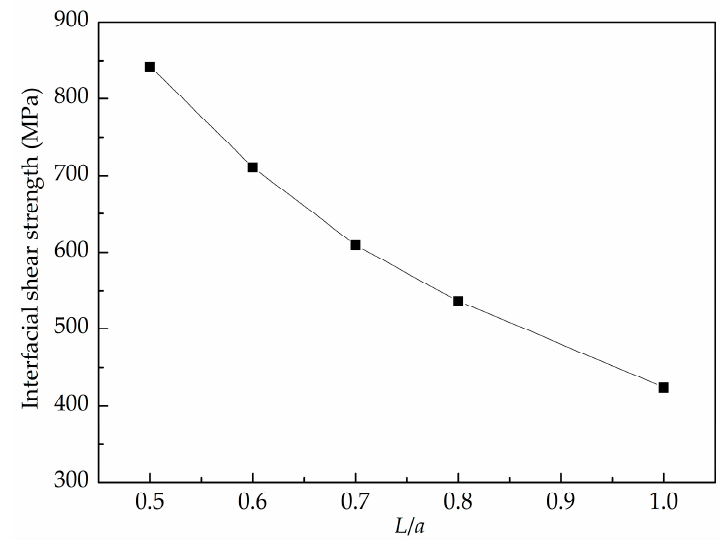
Figure 15. Interfacial shear strength of the composite with different embedded length of graphene.